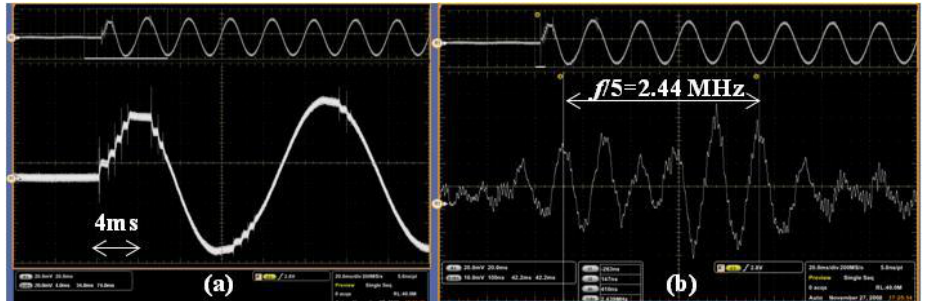
Figure 27. The E-field waveform during a close-operation of disconnector: ( a ) Recording of a power frequency cycle; ( b ) Expansion of